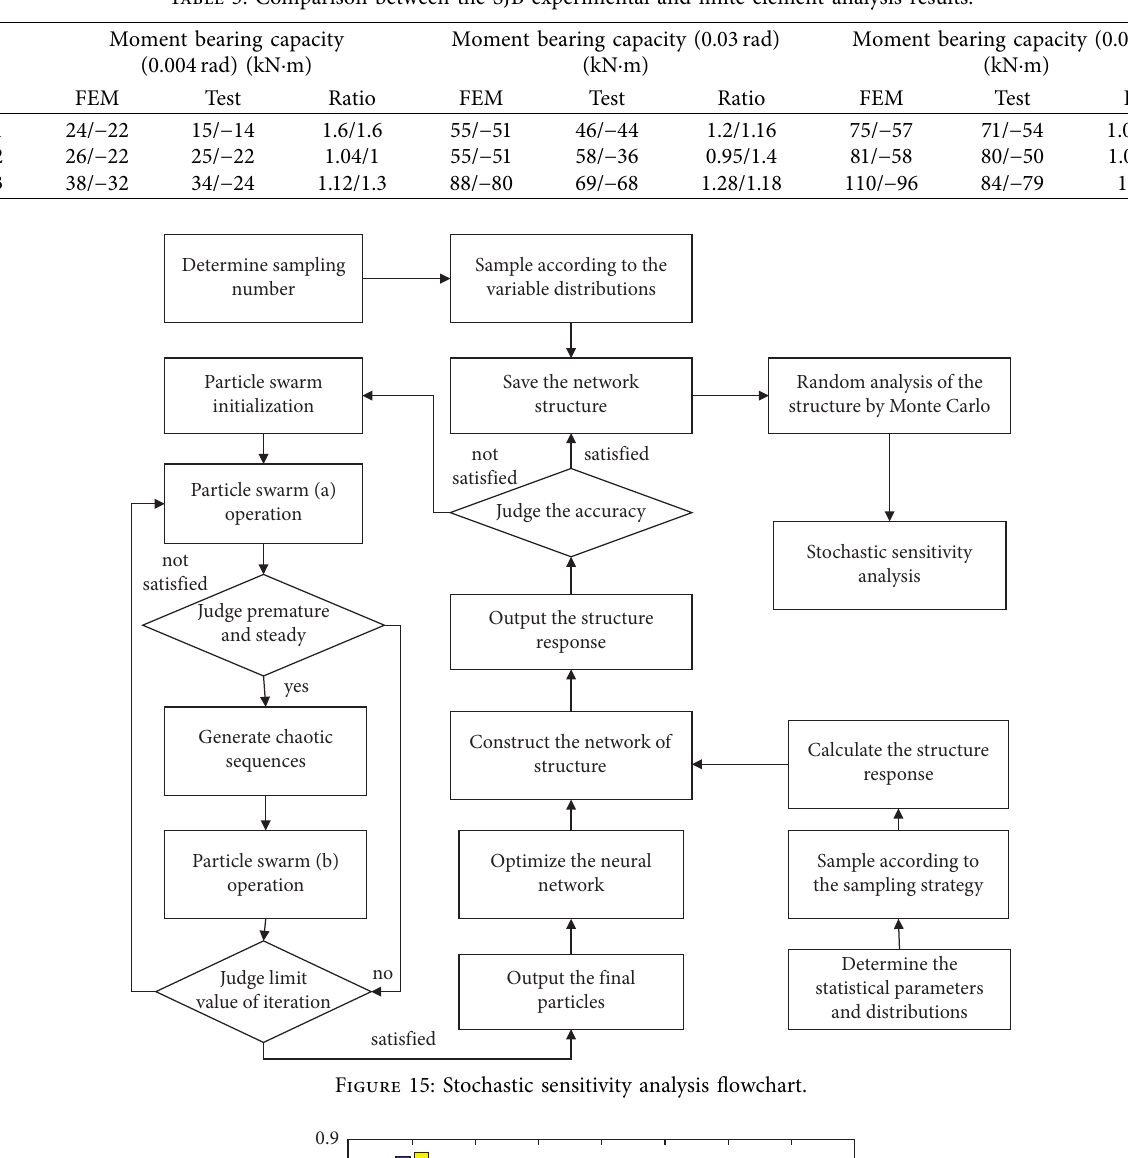
Figure 15: Stochastic sensitivity analysis flowchart.